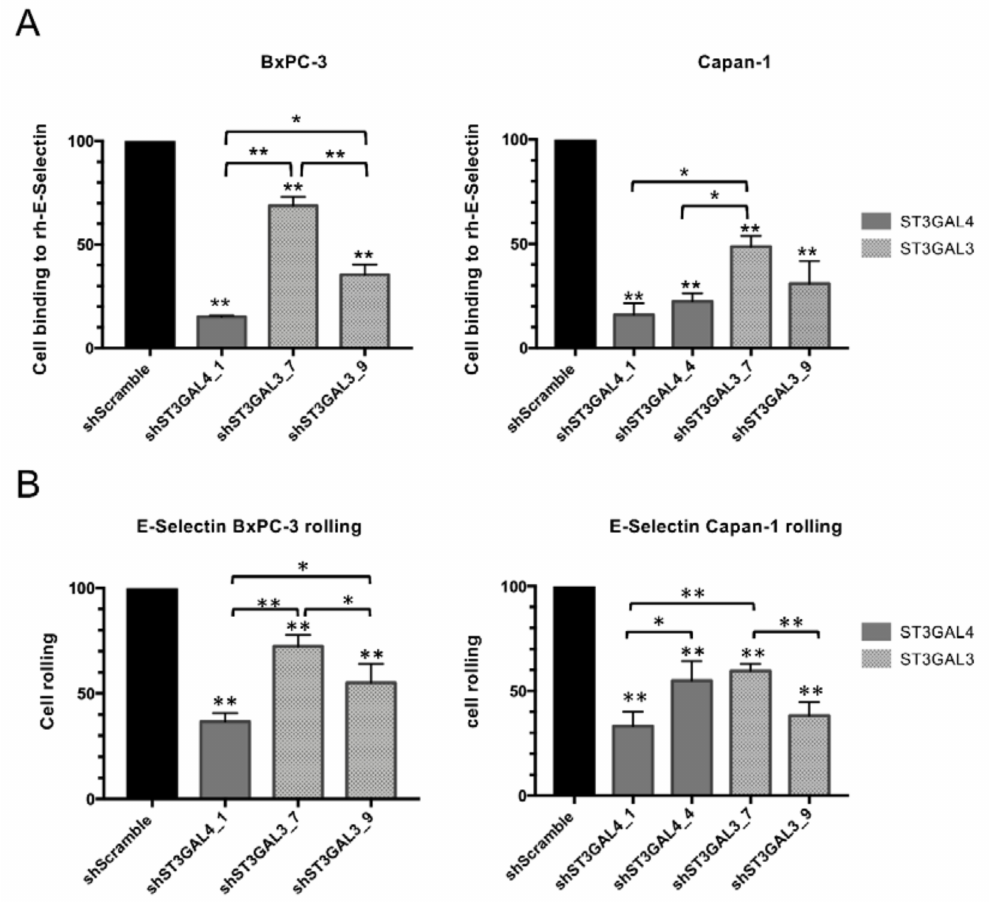
Figure 9. ST3GAL3 and ST3GAL4 knockdown inhibited cell adhesion to rh-E-selectin under static conditions and also impaired cell binding to rh-E-selectin under flow. ( A ) BxPC-3 (left) and Capan-1 cells (right) were incubated over E-selectin coated 96-well plates and allowed to adhere at 37 ◦ C. Adherent cells were quantified after 1 h incubation with MTS-based colorimetric assay. Experiments were performed in triplicate. Results are presented as mean ± SEM of adherent cells respect shScramble cells of three independent experiments. ANOVA and Tukey’s multiple comparison post-hoc test was performed * p < 0.05, ** p < 0.01. ( B ) Reduction in BxPC-3 (left) and Capan-1 (right) knockdown cells binding to rh-E-selectin in comparison to SC control cells flowing over immobilized E-selectin. Graphs depict means and SD from at least three independent